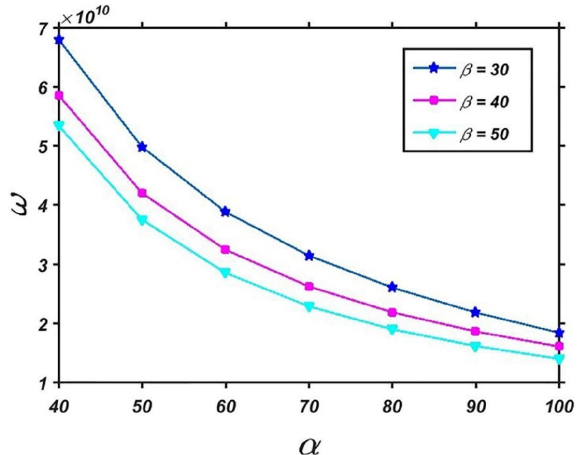
Figure 5: Variation of the natural frequency with α for different β parameters.